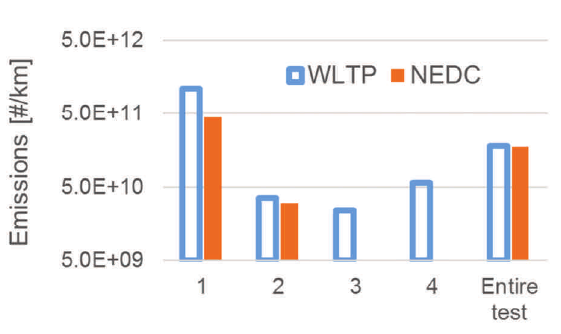
Fig. 9. PN emissions per phase and per test (solid particles only) for vehi- cle 3 (note that the NEDC consists of only two phases; note also the log 10